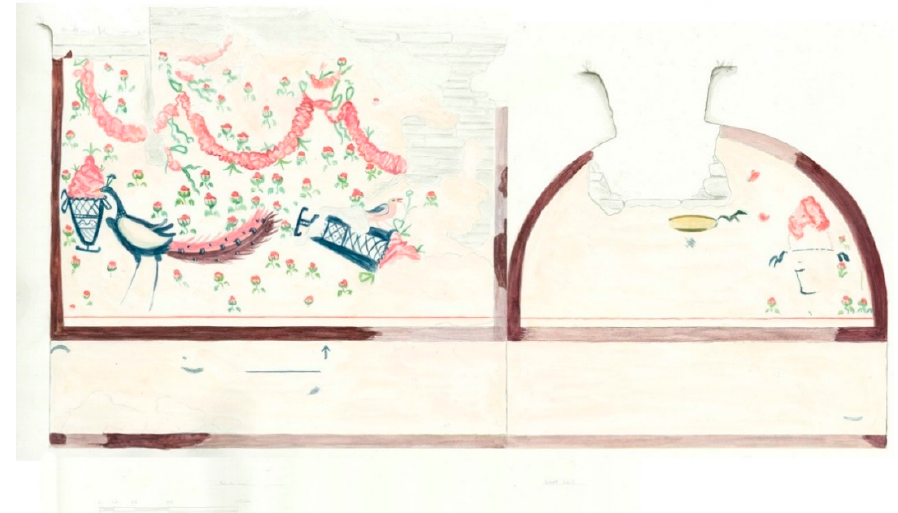
Figure A3. Sardis, Tomb 93.1 (Appendix A.4), painting of south and west walls. © Archaeological Exploration of Sardis/President and fellows of Harvard College.